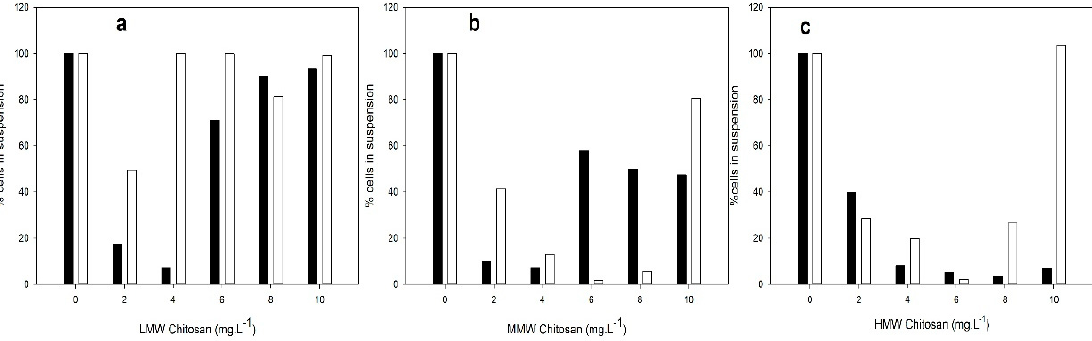
Figure 1. Effect of chitosan of different MW on the coagulation/flocculation of M. aeruginosa at the pH of the culture medium. CAAT 2005 ‐ 3 cultures ■ and PCC 7806 cells cultures ☐ (10 7 cells mL − 1 ) were added with different amounts of chitosan: low (LMW) ( a ), medium (MMW) ( b ), and high (HMW) ( c ). After 3 h, cells were counted from an aliquot of the supernatant.